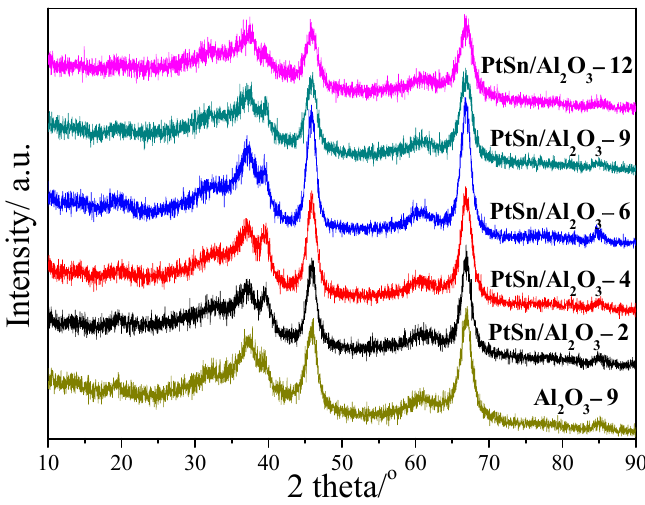
Figure 3. XRD patterns of Al 2 O 3 -9 and PtSn/Al 2 O 3 catalysts.